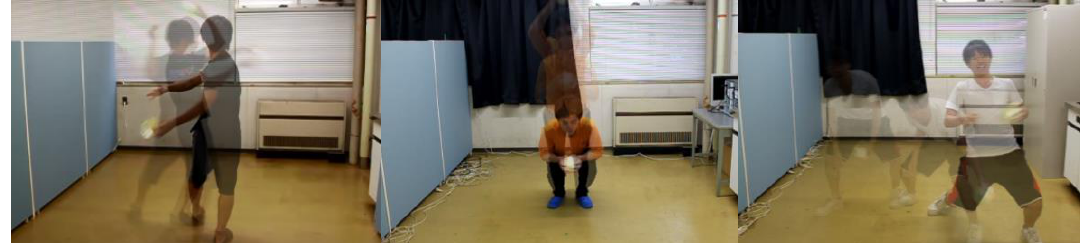
Figure 9. Dance improvisation using TwinkleBall. Subjects provided themes voluntarily: ( left ) “Fun”, ( middle ) “Bamboo shoot” and ( right ) “Gorilla”.